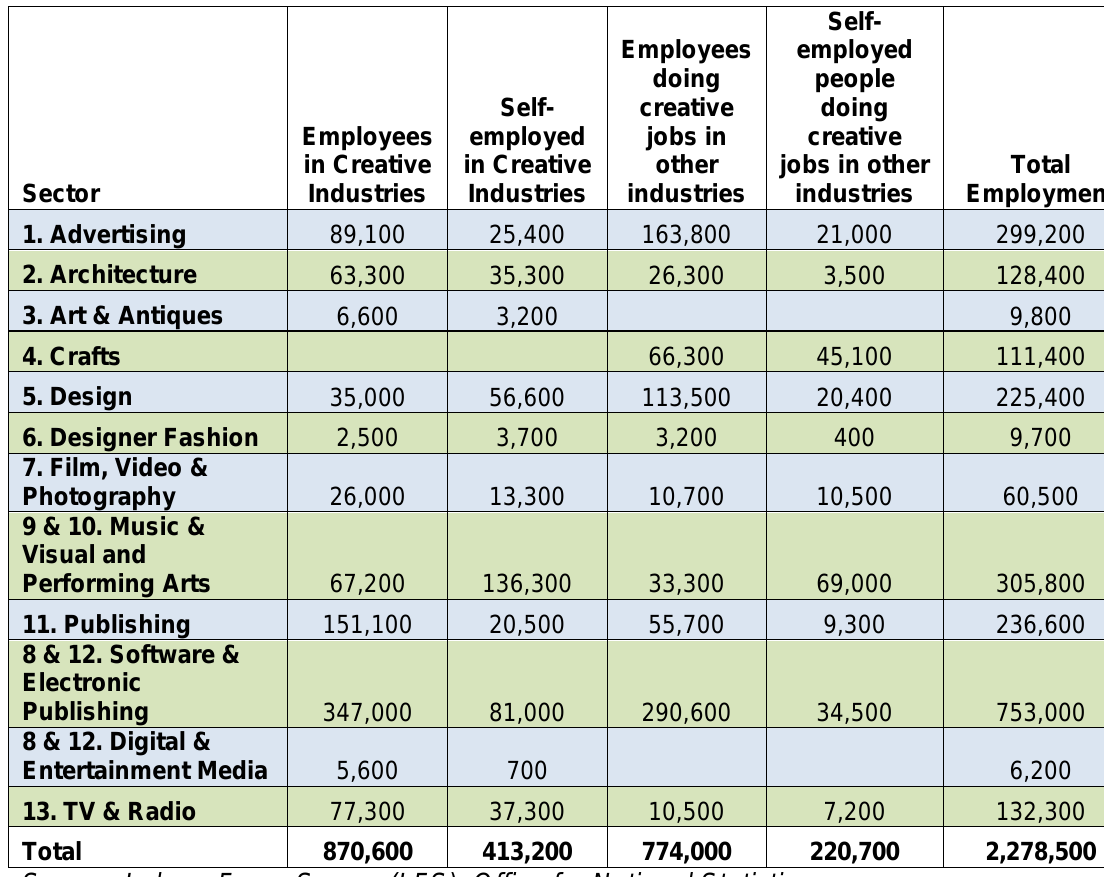
Table 2: Creative Employment, Great Britain 2010 Data (July -